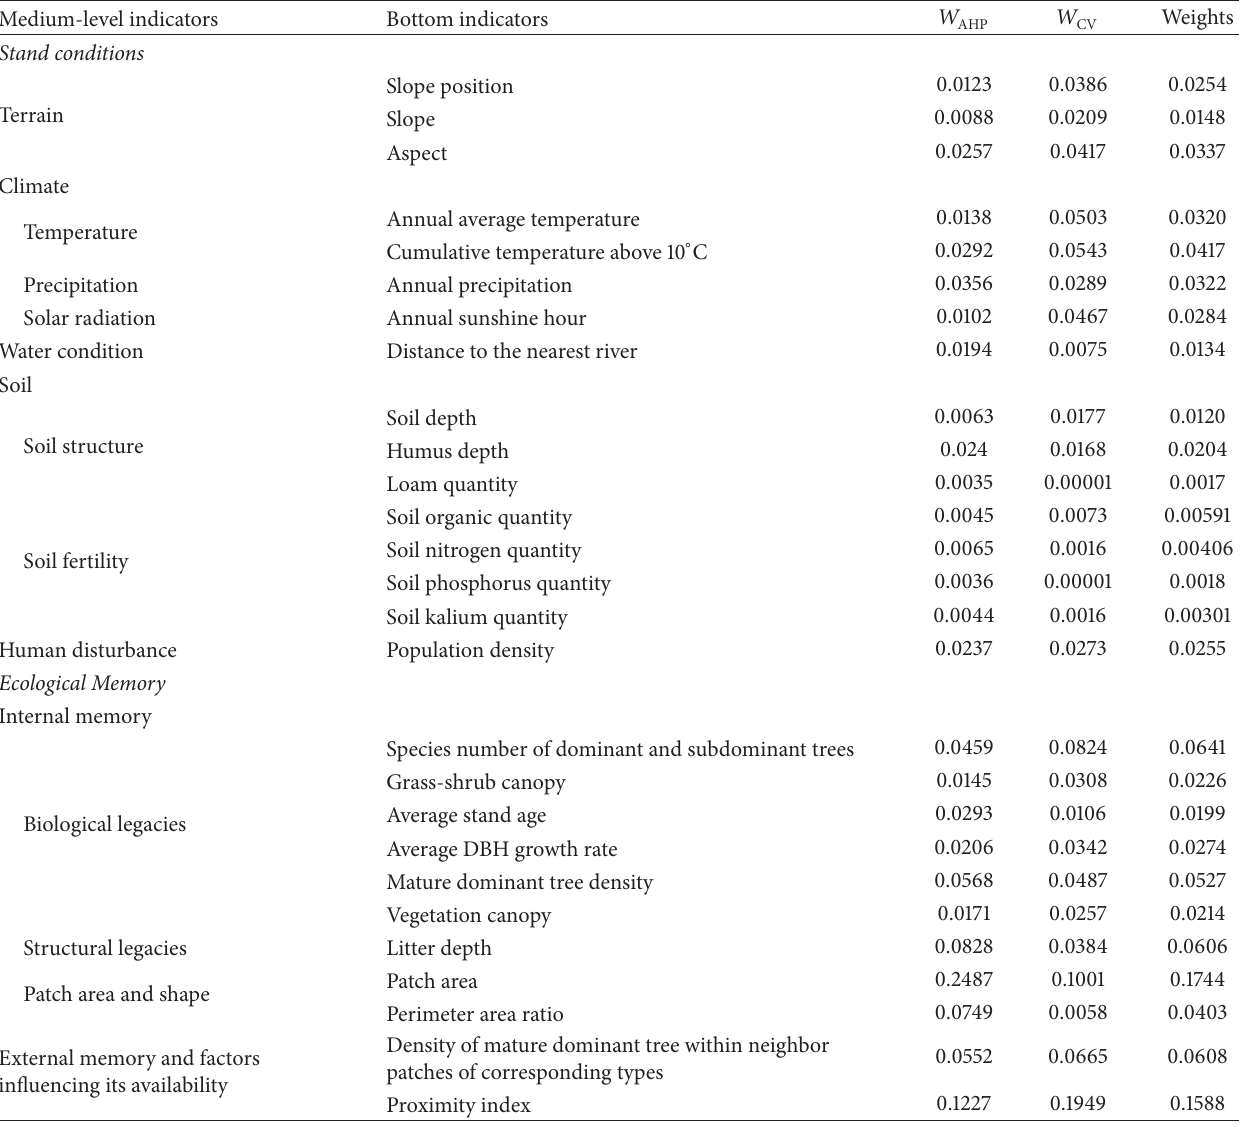
Table 1: The assessment system and weights of specific indicators. 𝑊 process (AHP) and coefficient of variation method (CV), respectively. The weights were calculated as the average of 𝑊